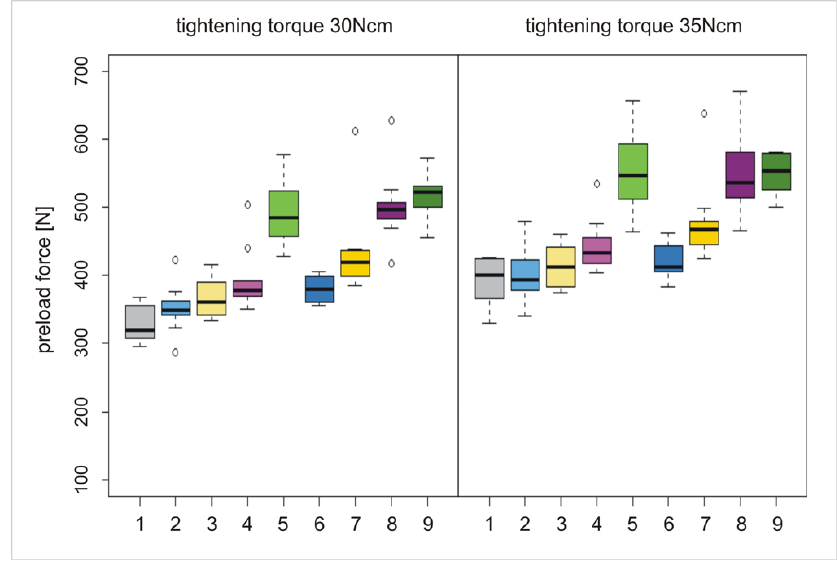
Figure 6. Boxplots of groups CG, TG1a – d, and TG2a – d with preload forces at a torque force of 30 Ncm, (left); boxplots of groups CG, TG1a – d, and TG2a – d with preload forces at a torque force of 35 Ncm (right).